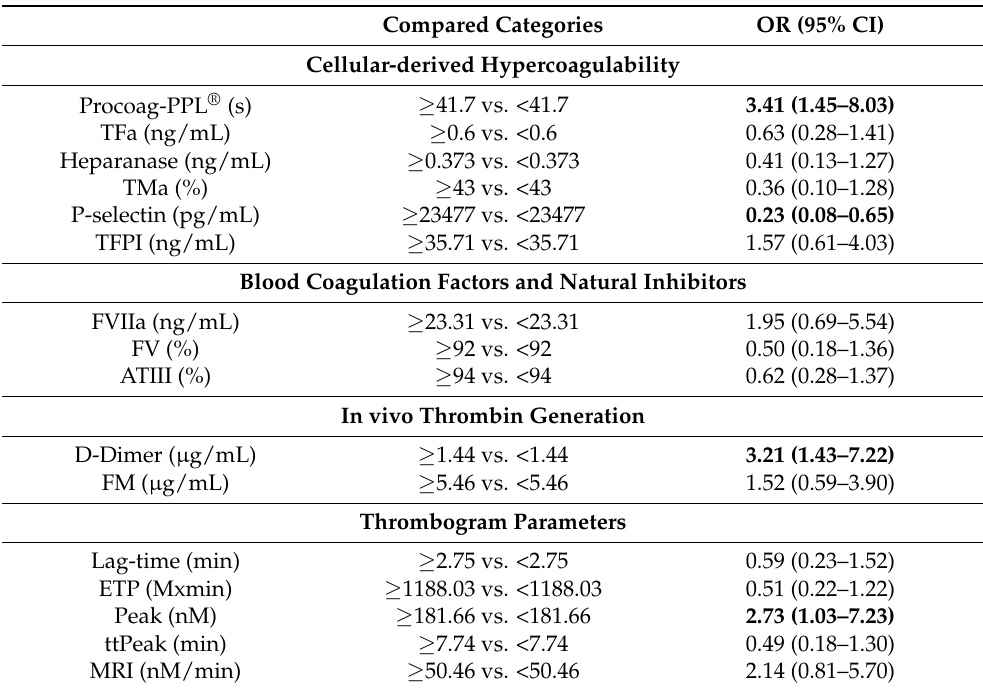
Table 3. Univariate logistic regression analysis evaluating associations between the examined biomarkers and poor response/resistance to first line anti-myeloma treatment.